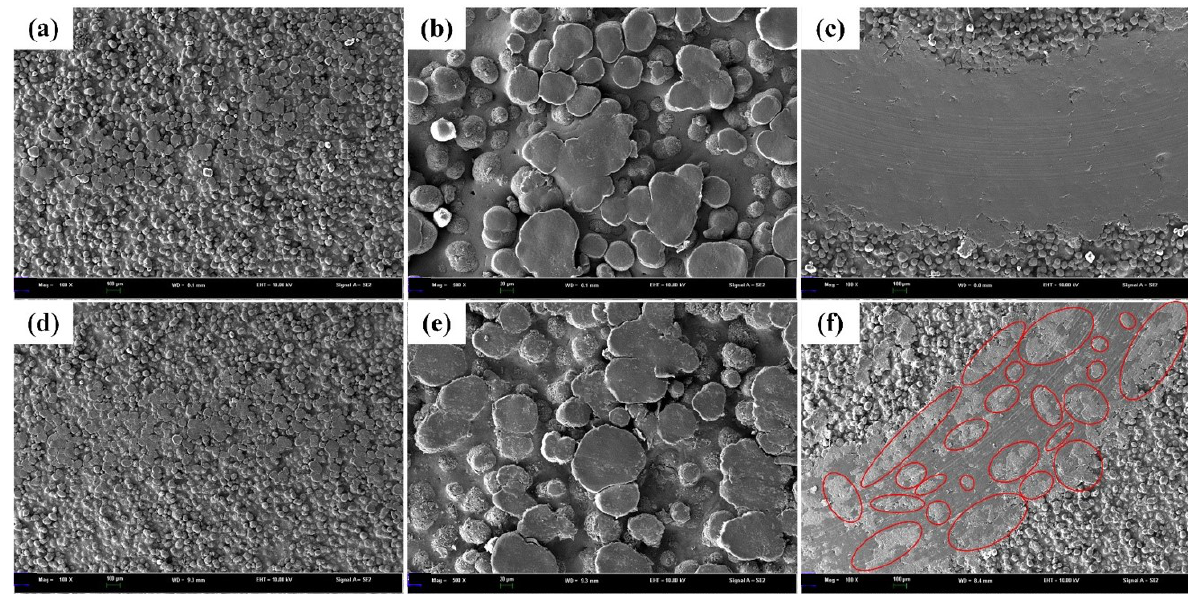
Figure 8. SEM images of wear tracks of PA12 ( a – c ) and SiC/PA12 composites ( d – f ), with magnifica- tions of 100, 500 and 100.